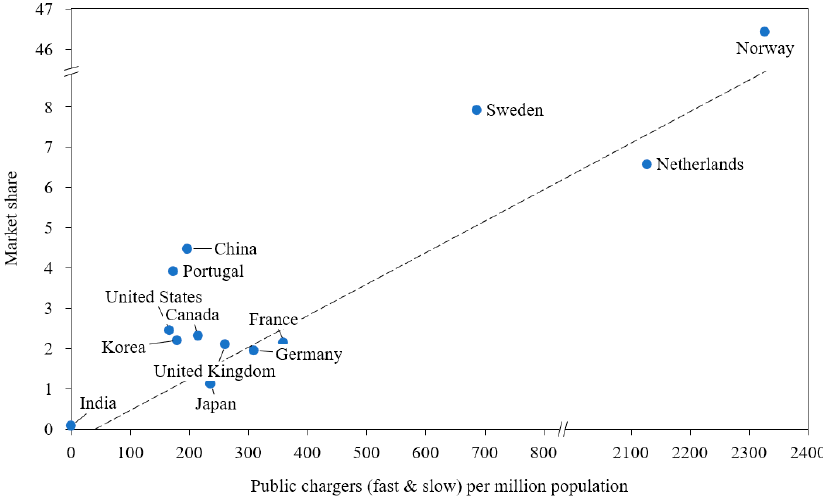
Figure 4. Market share and numbers of all public chargers per million population in 2018. Table 6. Results of variance inflation